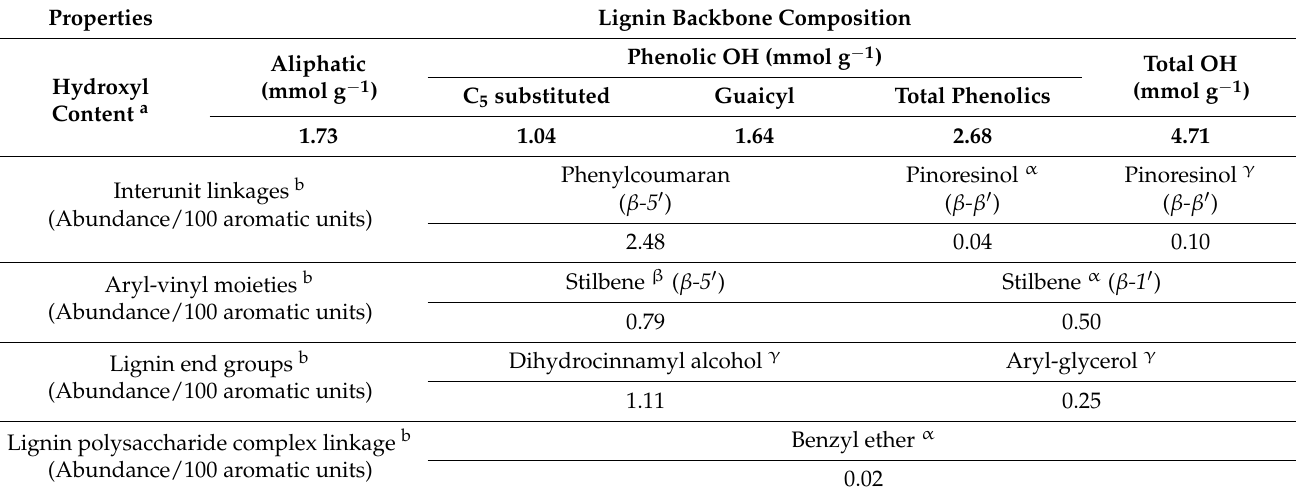
Table 2. Backbone composition of [N11H(2OH)][LAC]-extracted lignin from pine wood biomass using quantitative 13 C, HSQC, and 31 P-NMR analysis.